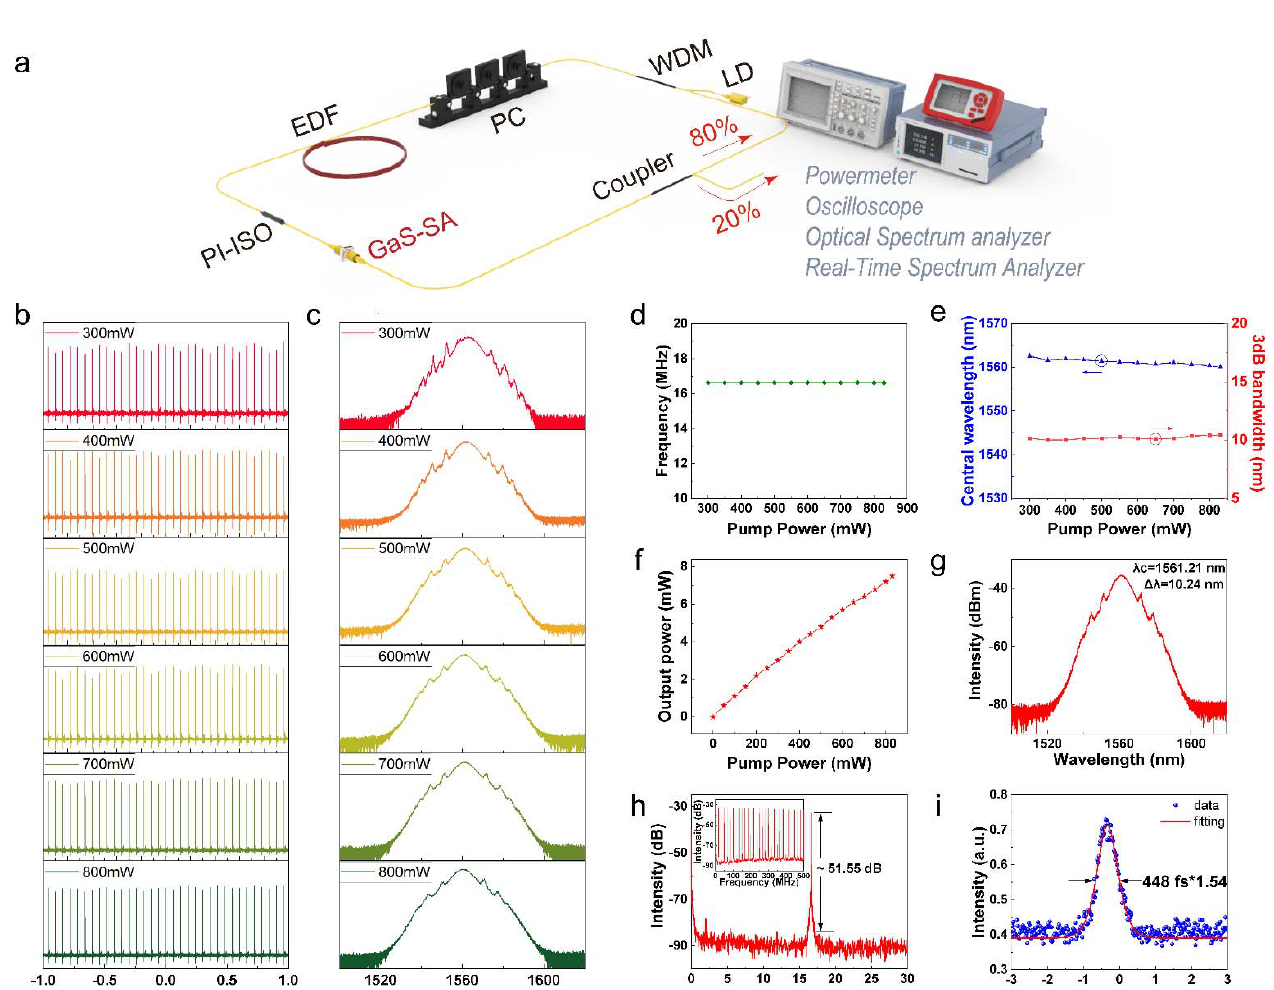
Figure 5. Characteristic of the femtosecond pulse generated from the Er-doped mode-locked fiber laser based on the GaS-SA. ( a ) Configuration of the laser ring cavity oscillator. ( b , c ) Pulse train and spectrum under different pump power. ( d , e ) Pulse repetition rate, central wavelength and 3 dB bandwidth as a function of pump power. ( f ) Output power vs. pump power. ( g ) Typical mode-locking optical spectrum at 550 mW pump power. ( h ) The corresponding radio frequency (RF) spectrum at f = 16.67 MHz. Insert: RF spectrum within 500 MHz range. ( i ) Typical autocorrelation trajectory of emission pulse at 830 mW.